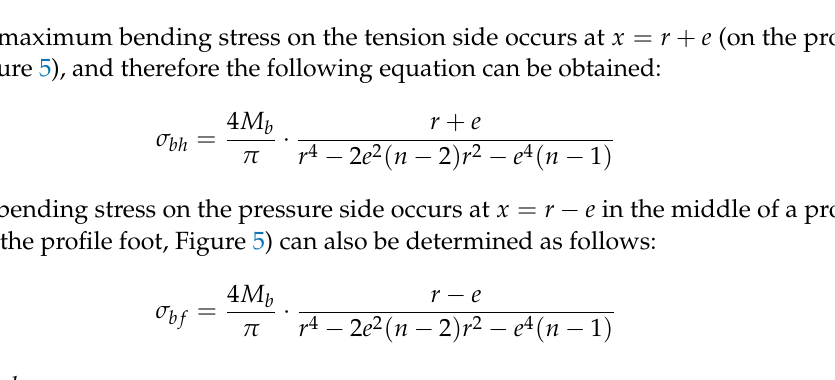
Figure 7. Circumferential distribution of the bending stress on the lateral surface of a standardised H3 profile. -150 -100-500 50